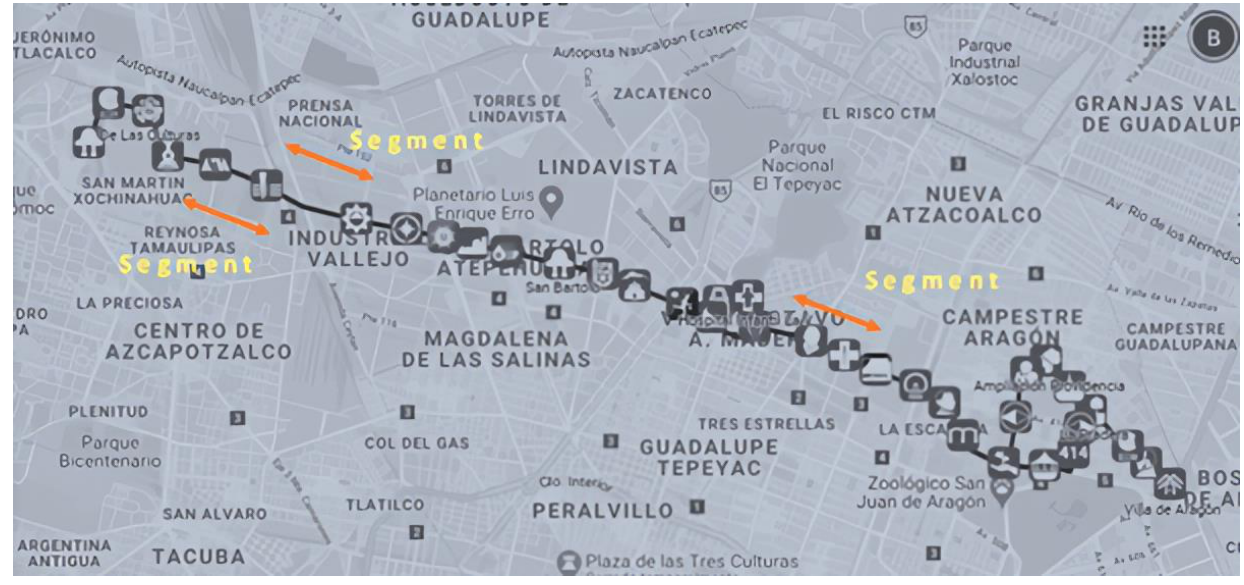
Figure 7. Segments of Metrobus Line 6.